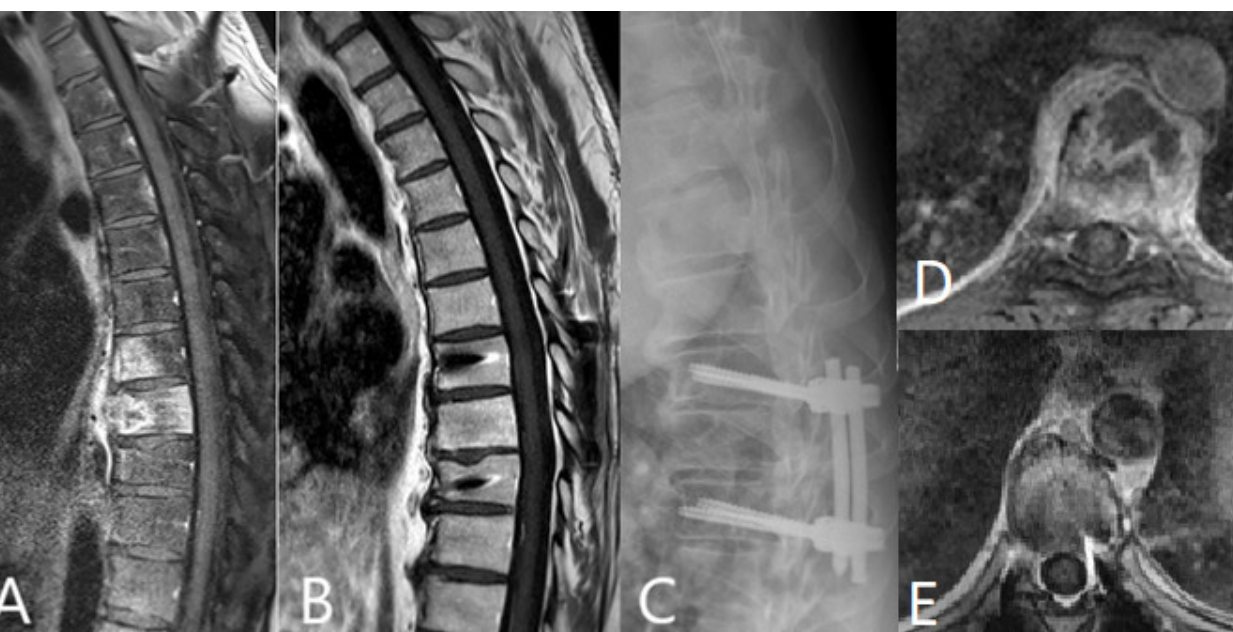
Figure 3. 66-year-old male patient with spondylodiscitis and epidural empyema due to an infection with pseudomonas aeruginosa at L4/5 and L5/S1 following the stabilization of L3/4 with an intervertebral cage due to degenerative spinal canal stenosis. ( A ). preoperative T1 post-contrast MRI of the lumbar spine shows spondylodiscitis at L4/5 and L5/S1 with intraspinal empyema. ( B ). preoperative CT of the lumbar spine shows infectious degeneration of L4/5 segment. ( C ). post- operative lumbar spine following extension of the fusion to S1 with cage implantation in L4/5 and L5/S1. ( D ). postoperative sagittal X ray of the lumbar spine shows the spinal construct. ( E ). postoperative MRI of the lumbar spine shows the com- plete resolution of infection 9 months following surgery. ( F ). T1 weighted post-contrast of the MRI of the lumbar spine at L5 level shows intraspinal empyema. ( G ). Postoperative T2 weighted MRI of the spine shows infection resolution. Surgical complications occurred in 51 patients (21.5%). Twenty-eight patients (11.8%) underwent revision surgery due to hardware failure (screw correction and dislocation of the implant). In 44 cases, wound healing deficits occurred (18.6%), 5 patients had cerebro- spinal fluid leaks (2.1%), and 8 patients had postoperative hematoma (3.4%). Eighteen pa- tients (7.6%) required three or more surgeries due to complications. Recurrent spondylodiscitis occurred in 18 patients (7.6%), and of these, 9 cases had treated and adjacent segments and another 9 cases had adjacent segments only. Adjacent segment disease, which required further stabilization surgery, occurred in 11 patients dur- ing the follow-up (4.7%), and 7 patients were treated conservatively for recurrent spon- dylodiscitis.